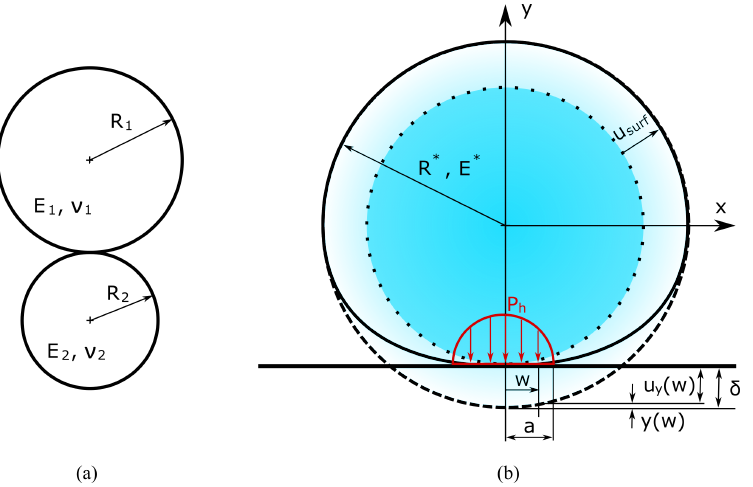
Figure 3. Contact of spherical surfaces. Real model ( a ) and equivalent model ( b ). Dotted lines refers to rest condition (no lithium inserted in particle). Dashed line refers to the free expansion of the particle as a result of lithiation. Solid line refers to particle surface considering both expansion due to lithiation and contact. The red line represents the pressure distribution in the contact area, and P h is the maximum